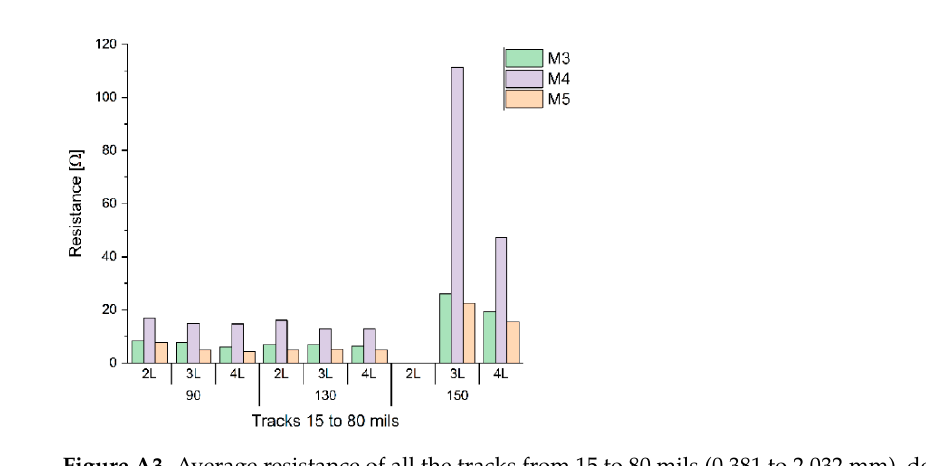
Figure A2. Percentage of all tracks without faults (correct tracks), greater than or equal to 20 mils (0.508 mm), based on inks, number of prints, and mesh size.